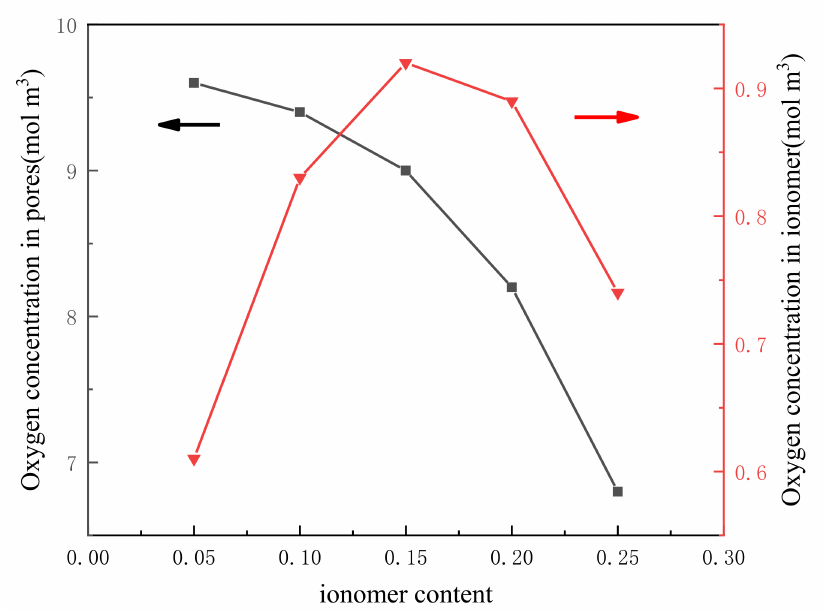
Figure 13. Oxygen distribution in pores and in ionomer.